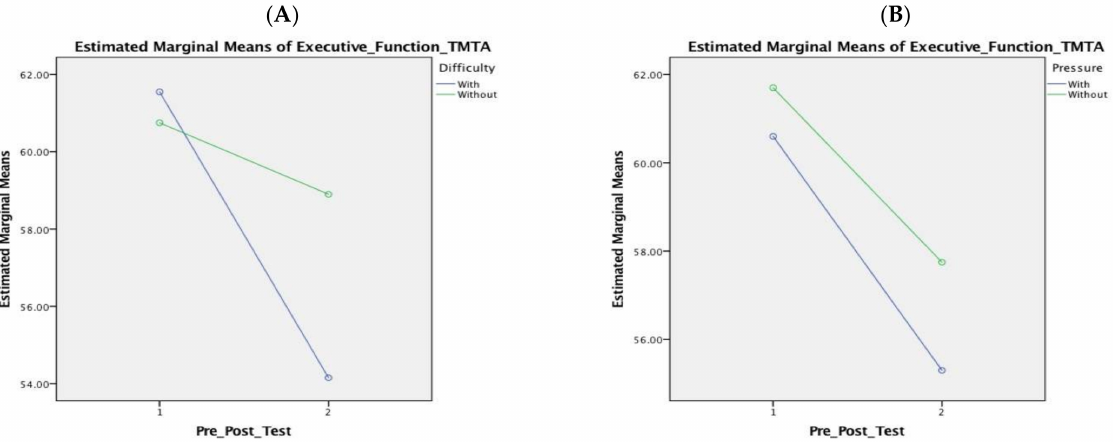
Figure 11. The graph of two-factors interaction in TMT-A. Figure ( A ) shows the interaction of pre/post-test * difficulty; Figure ( B ) shows the interaction of pre/post-test * pressure. Note: pre/post- test (the horizontal axis), pre-test = 1, and post-test = 2.